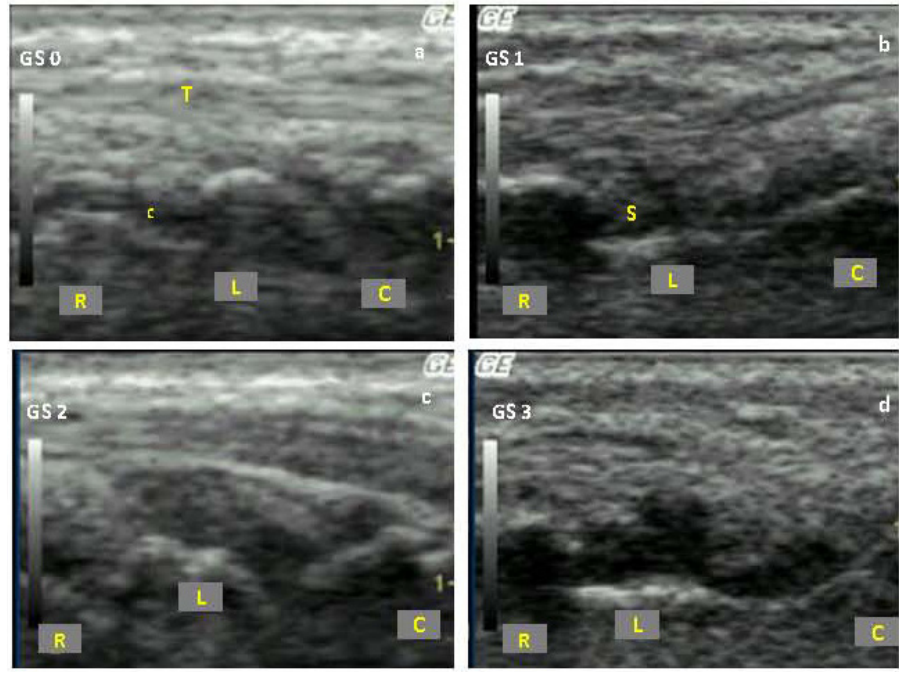
Figure 1. Synovitis identified by gray scale (GS) ultrasound in a dorsal longitudinal wrist scan. a = grade 0; b = grade 1; c = grade 2; d = grade 3. T = tendon; S = synovitis; R = radius; L = lunate; C = capitate bone; c = cartilage.